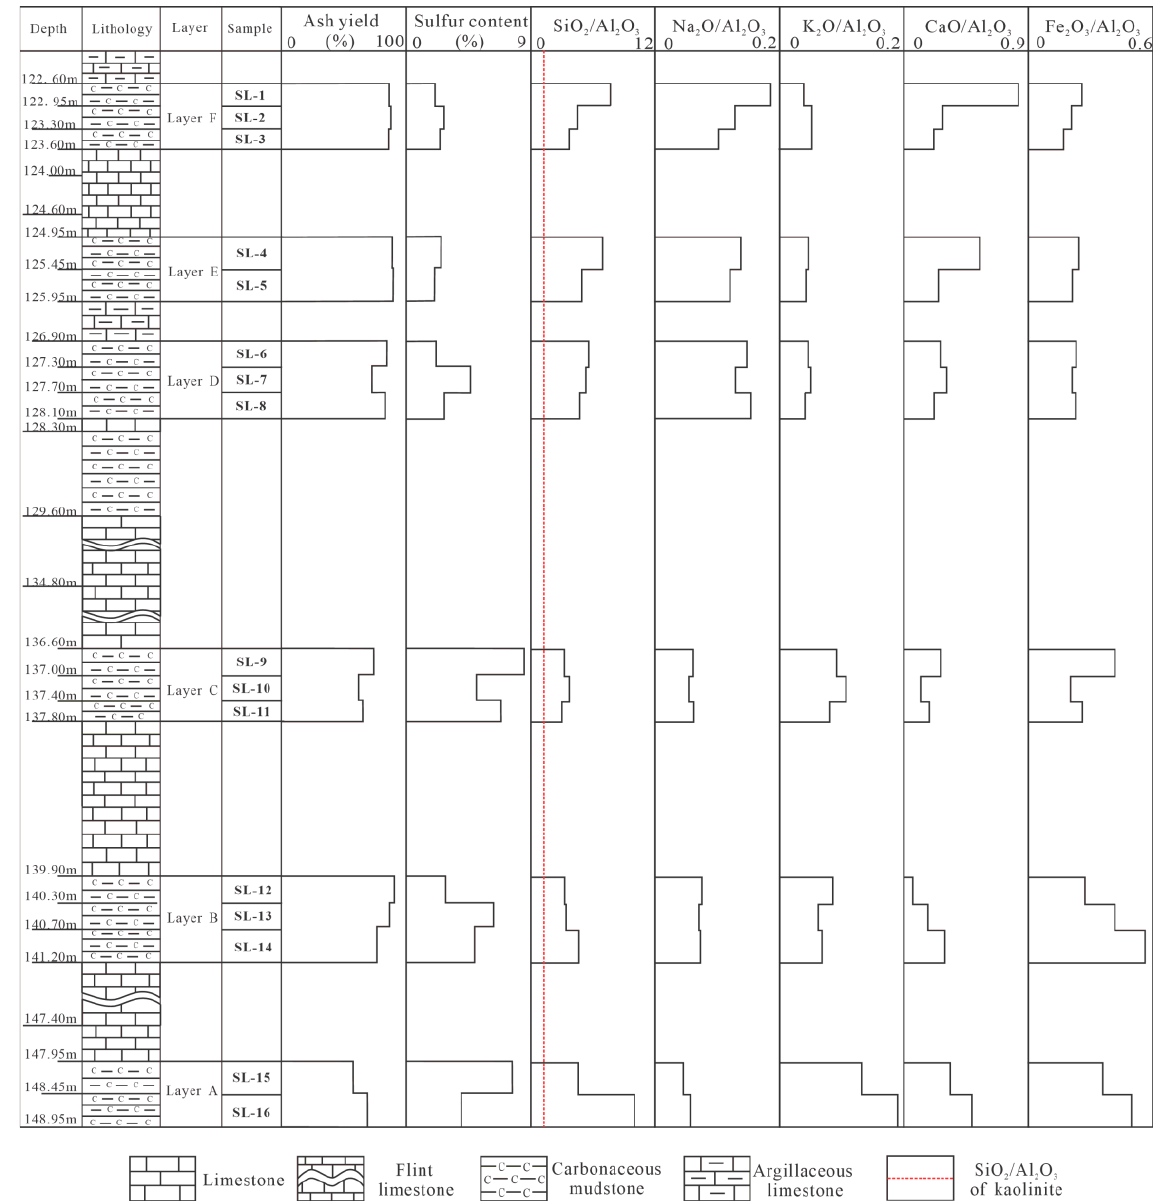
Figure 3. Vertical distribution of ash yield, sulfur content, and the ratios of major element oxides throughout borehole SL profile.